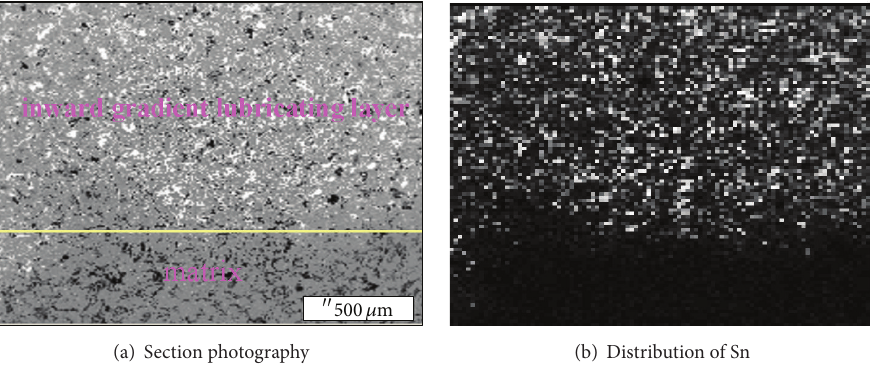
Figure 5: Section photography of the gradient layer and the distribution of Sn in depth